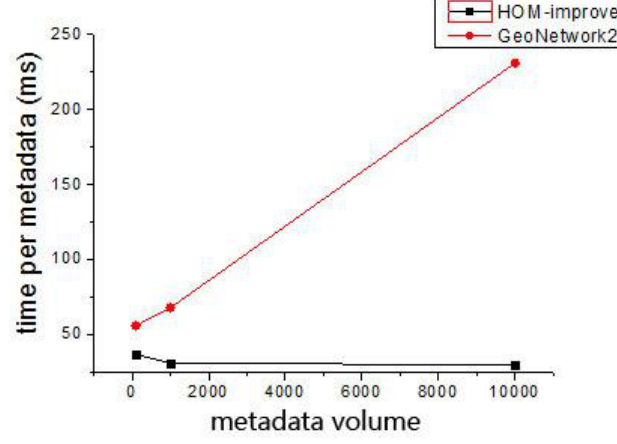
Figure 3. Time per metadata contrast on data importing From Table 1, we can see the efficiency of batch import function through HOM-improved software compared to the original GeoNetwork 2.1 can increase 2-10 times, and the greater the amount of metadata, the higher the efficiency. From Figure 3, in GeoNetwork 2.1 metadata batch import function has time consumption growth rate is far greater than the amount of data, while the HOM-improved on the contrary, growth